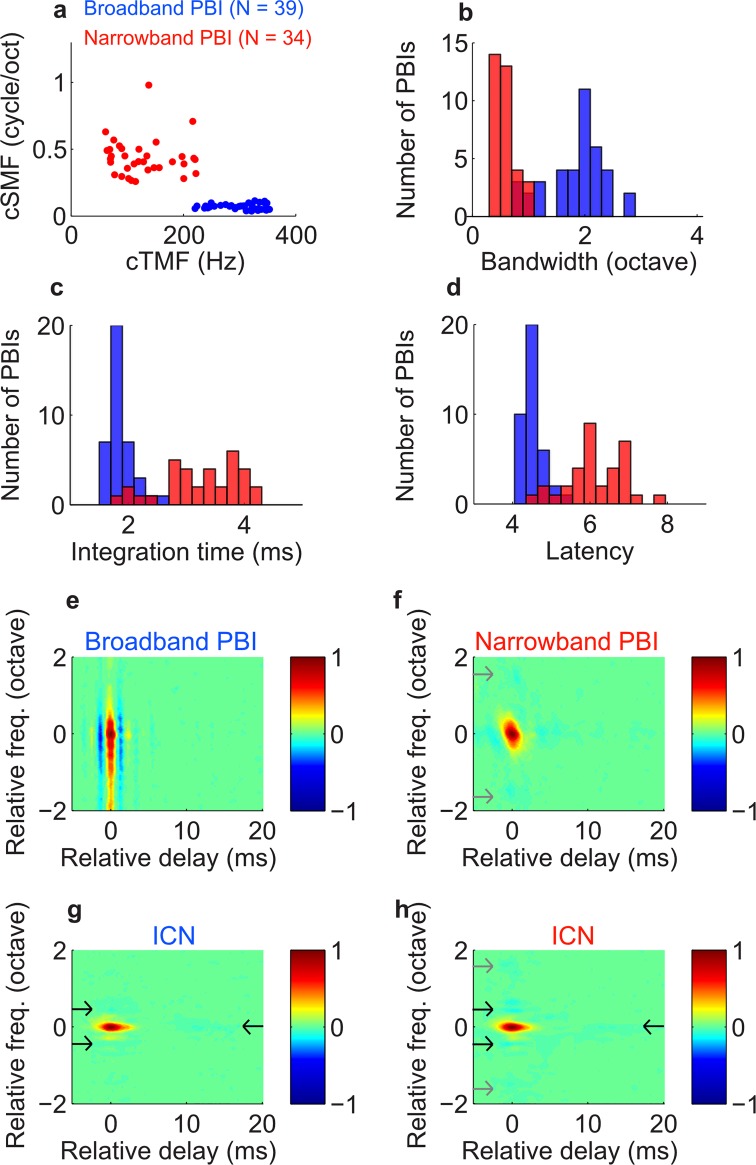
Functionally distinct groups of PBIs have unique spectrotemporal preferences.(a) Cluster analysis on the spectrotemporal modulation parameters (cTMF and cSMF) of the PBIs reveals 2 groups: one with faster temporal modulation preference (blue) and one with finer spectral modulation preference (red). The blue group has broader bandwidth than the red cluster (panel b), and we thus refer to the 2 groups as broadband PBI and narrowband PBI, respectively. Broadband PBI have shorter integration time (panel c) and shorter response latency (panel d) than narrowband PBI. The population-average STRF (normalized and aligned to the STRF peak) is shown for the 2 groups of PBIs (panel e = broadband PBI; panel f = narrowband PBI). The average STRFs for the corresponding paired ICNs are shown for sites with broadband PBI (panel g) and narrowband PBI (panel h). In general, the average ICN has longer integration time, substantially narrower bandwidth, and newly constructed inhibitory regions (panels g and h, black arrows) than the paired PBIs. Underlying data can be found in S4 Data and S4 Code. cSMF, characteristic spectral modulation frequency; cTMF, characteristic temporal modulation frequency; ICN, inferior colliculus neuron; PBI, putative brainstem input; STRF, spectrotemporal receptive field.